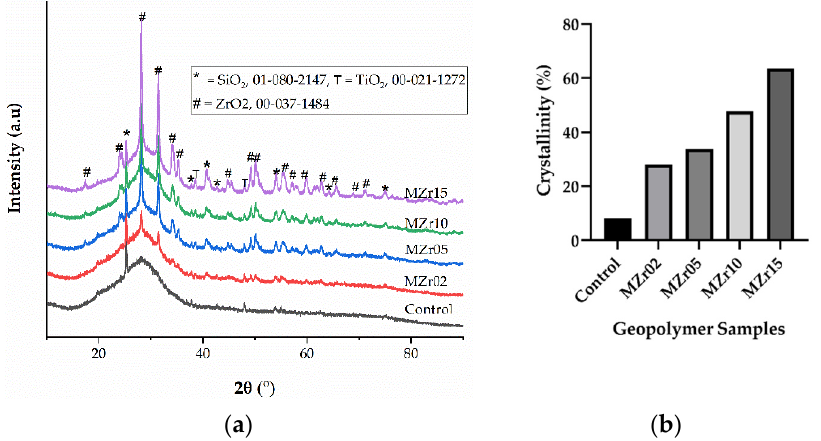
Figure 2. The XRD pattern of geopolymer samples with and without nano-zirconia addition ( a , b ) (* = SiO 2 , T = TiO 2 , and # = ZrO 2 ).